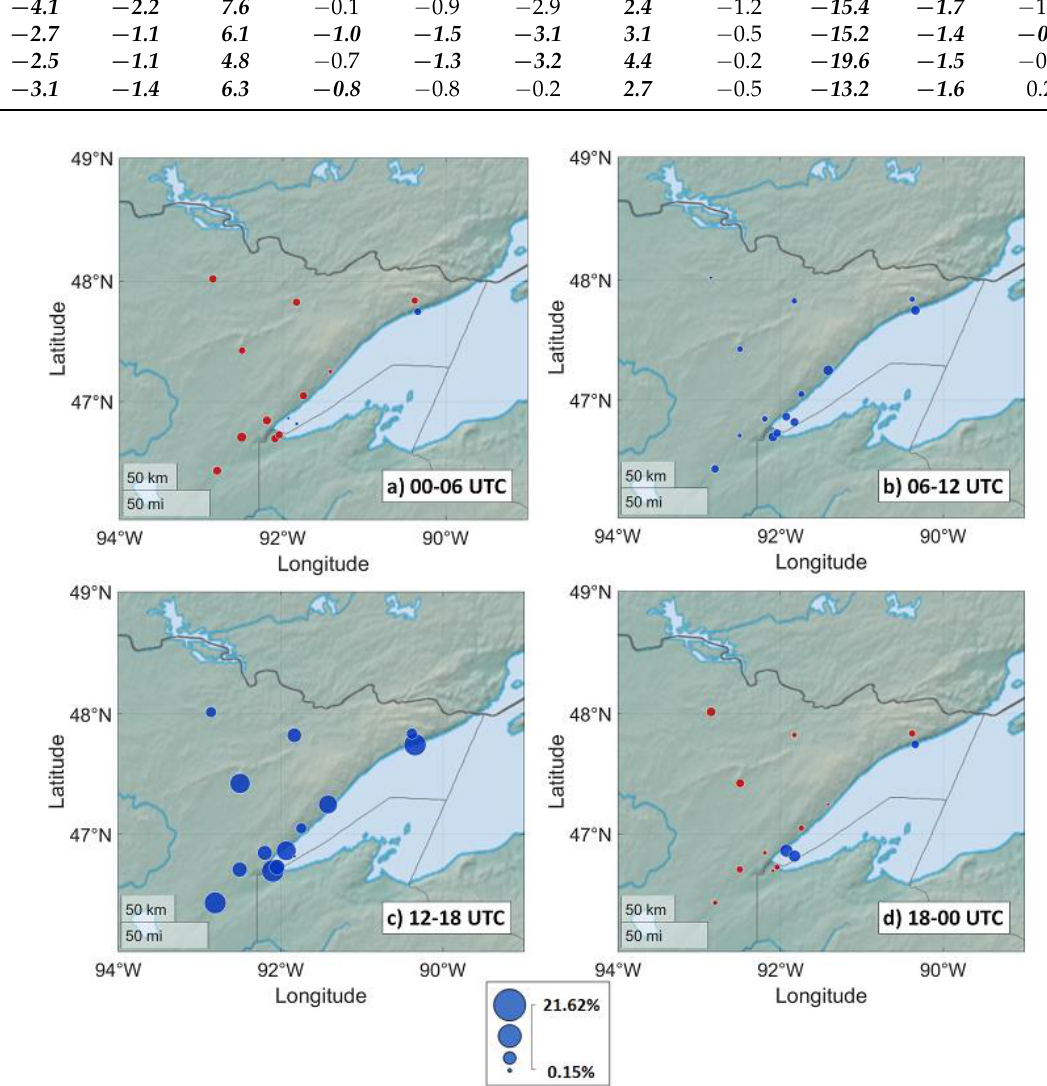
Figure 7. As in Figure 4, except for average relative humidity change by time of day: ( a ) 00 – 06 UTC; ( b ) 06 – 12 UTC; ( c ) 12 – 18 UTC; ( d ) 18 – 00 UTC. Red (blue) bubbles indicate increasing (decreasing)